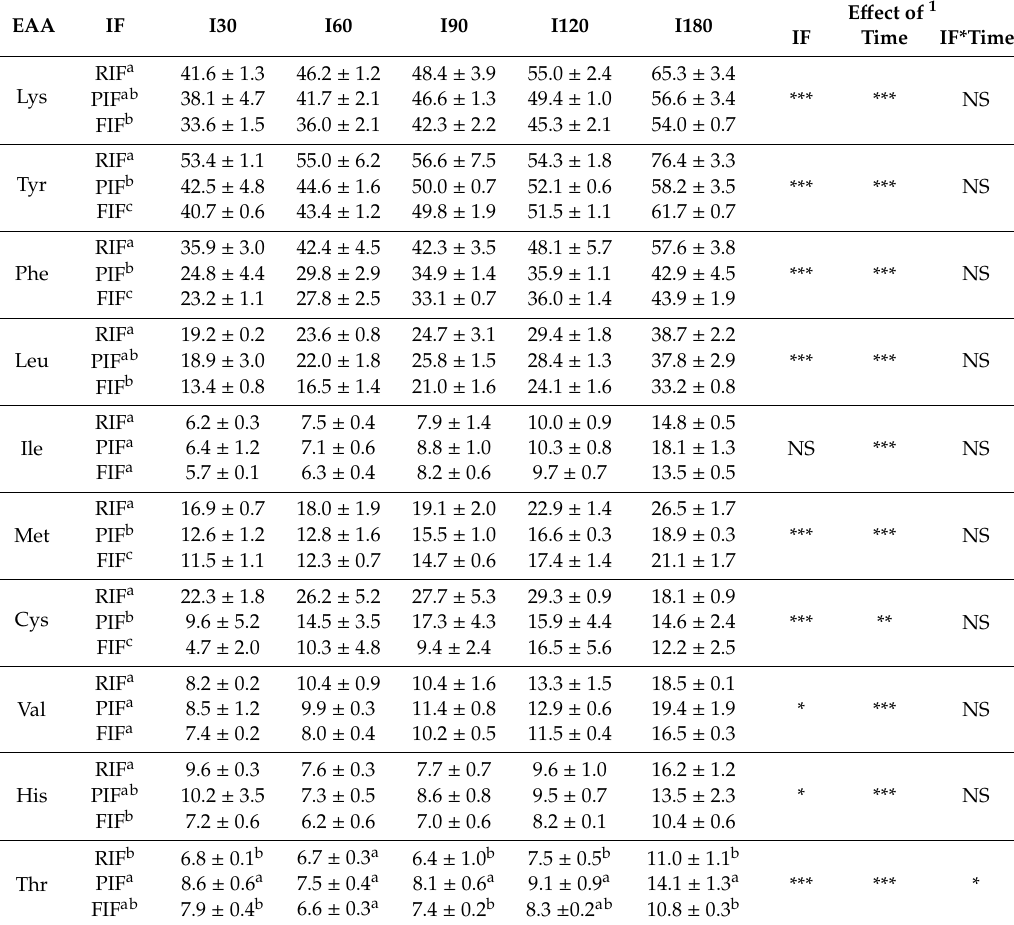
Table 4. Bioaccessibility of essential amino acids (EAA) in the intestinal compartment (I) during in vitro dynamic digestion for RIF, PIF, and FIF. Bioaccessibility is expressed as % w / w of total amino acid. Data are means ± SD ( n = 3).